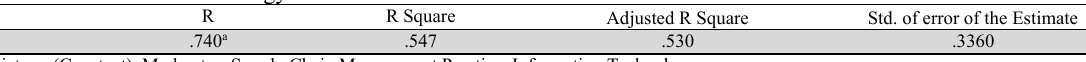
R-square of information technology